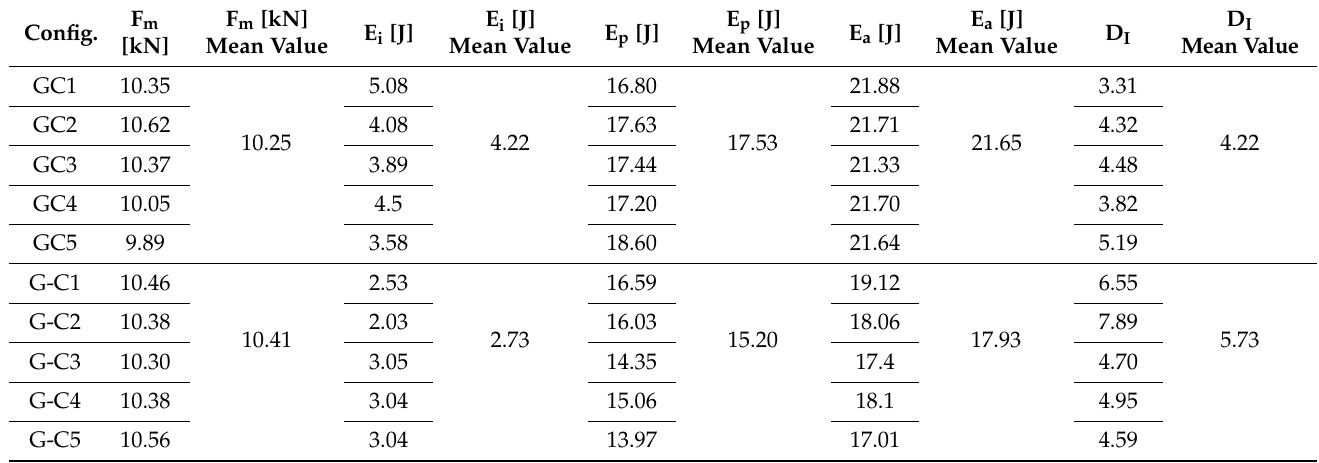
Figure 4. Force–deflection curves of the hybrid composites tested at 33 J impact energy in low-velocity impact tests. Table 2. Maximum load, E i , E p , E a , and D I of each hybrid composite tested sample.